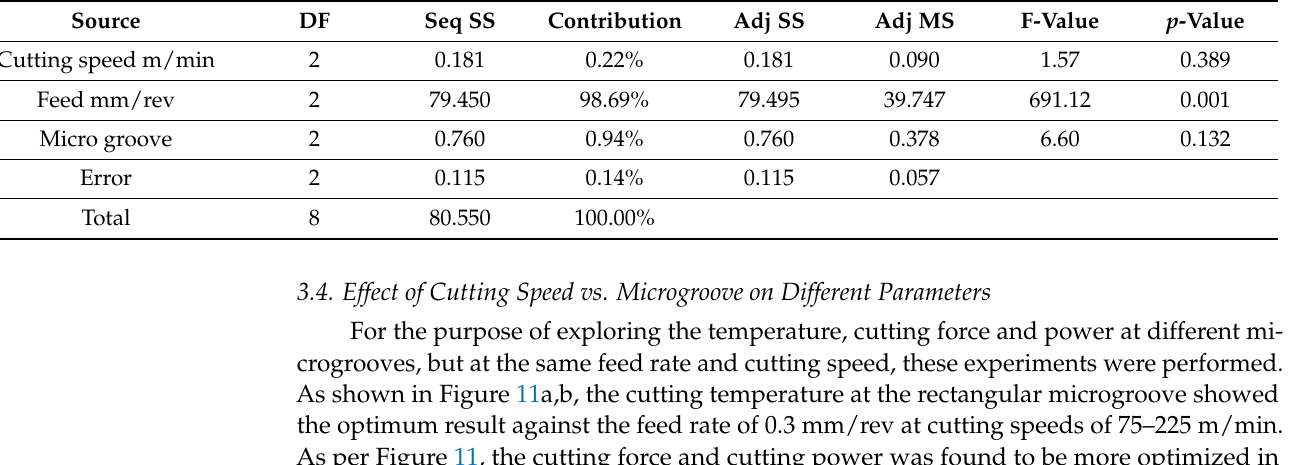
Figure 10. Mean and signal to noise plots for total cutting power values.